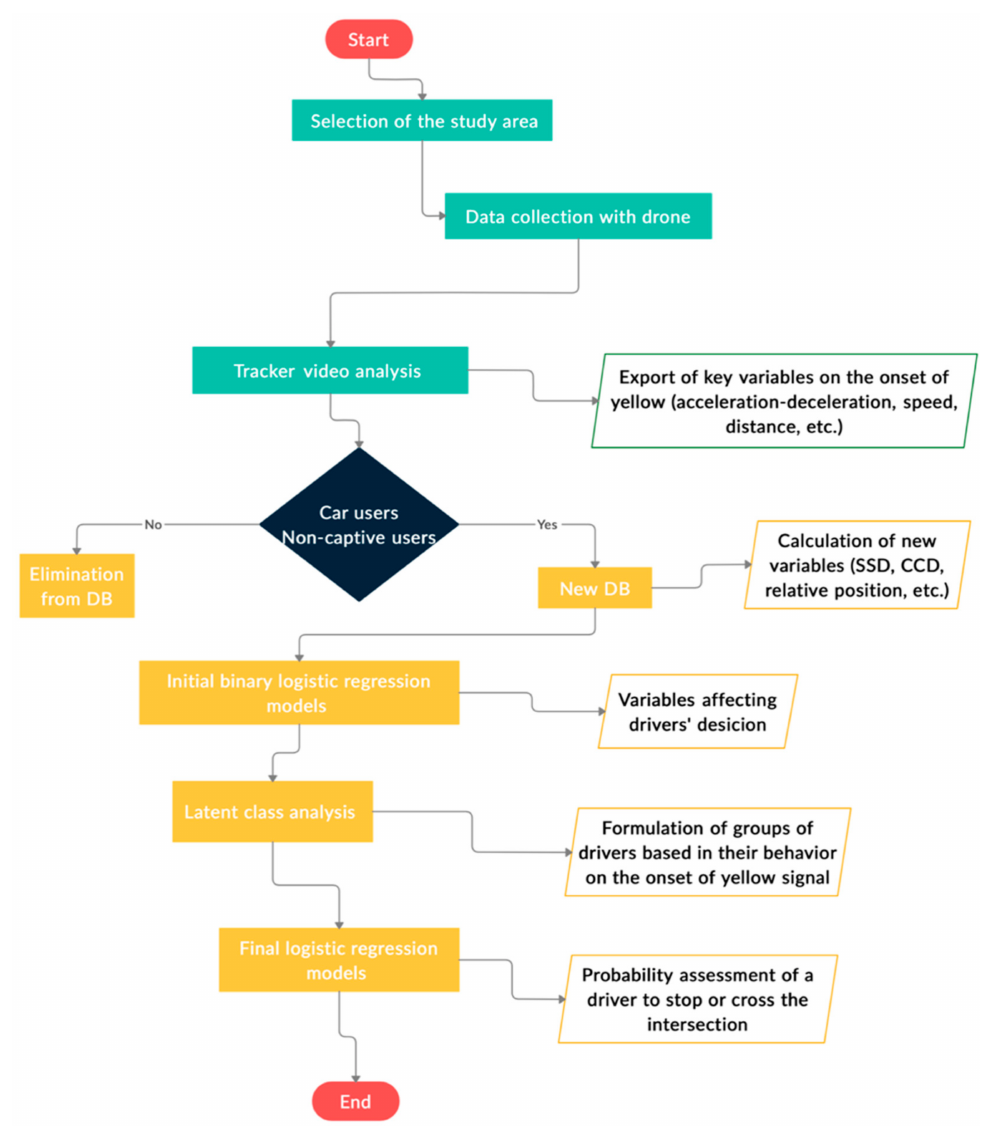
Figure 2. Methodological approach of the